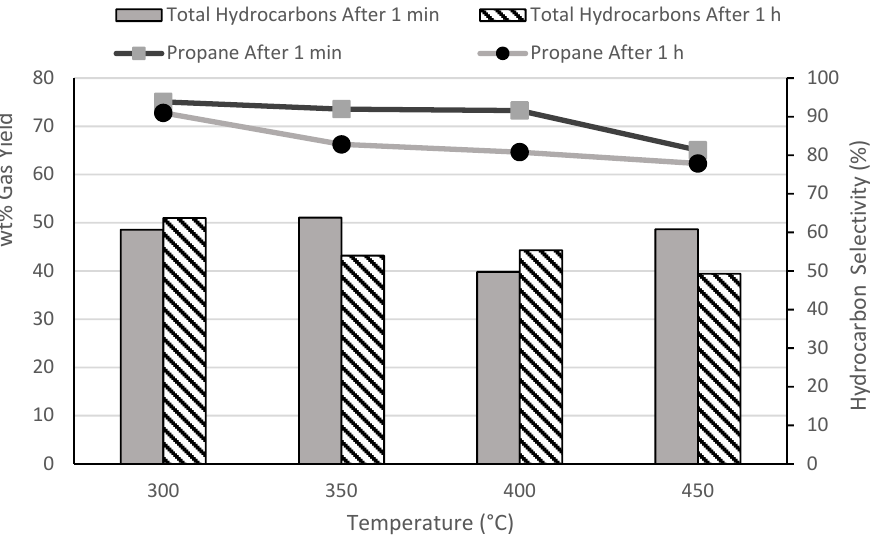
Figure 4. Effect of temperature at 1 min and 1 h residence time (0.5 g butyric acid; 10 mL water and 1.0 g Pt/C (50 mg Pt metal content)).